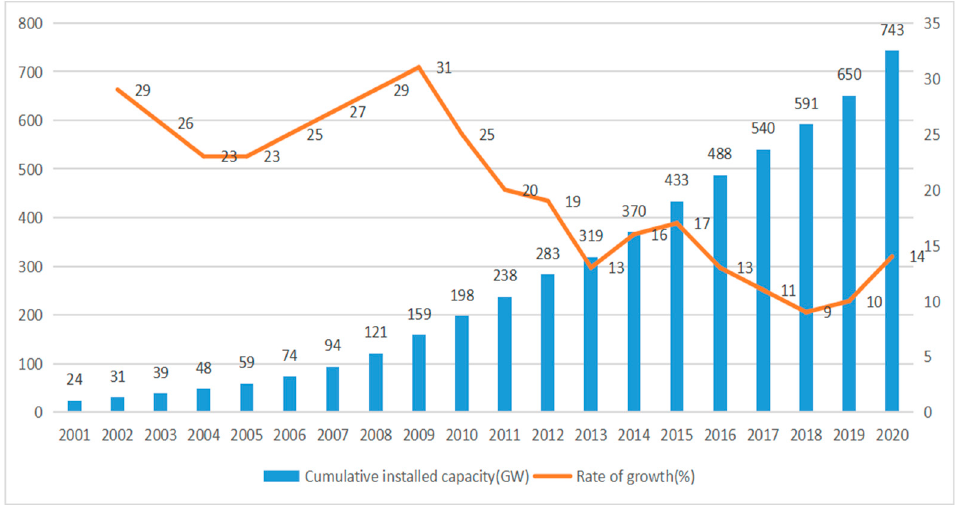
Figure 1. Global cumulatively installed wind power capacity and rate of growth in 2001–2020 (GW, %).